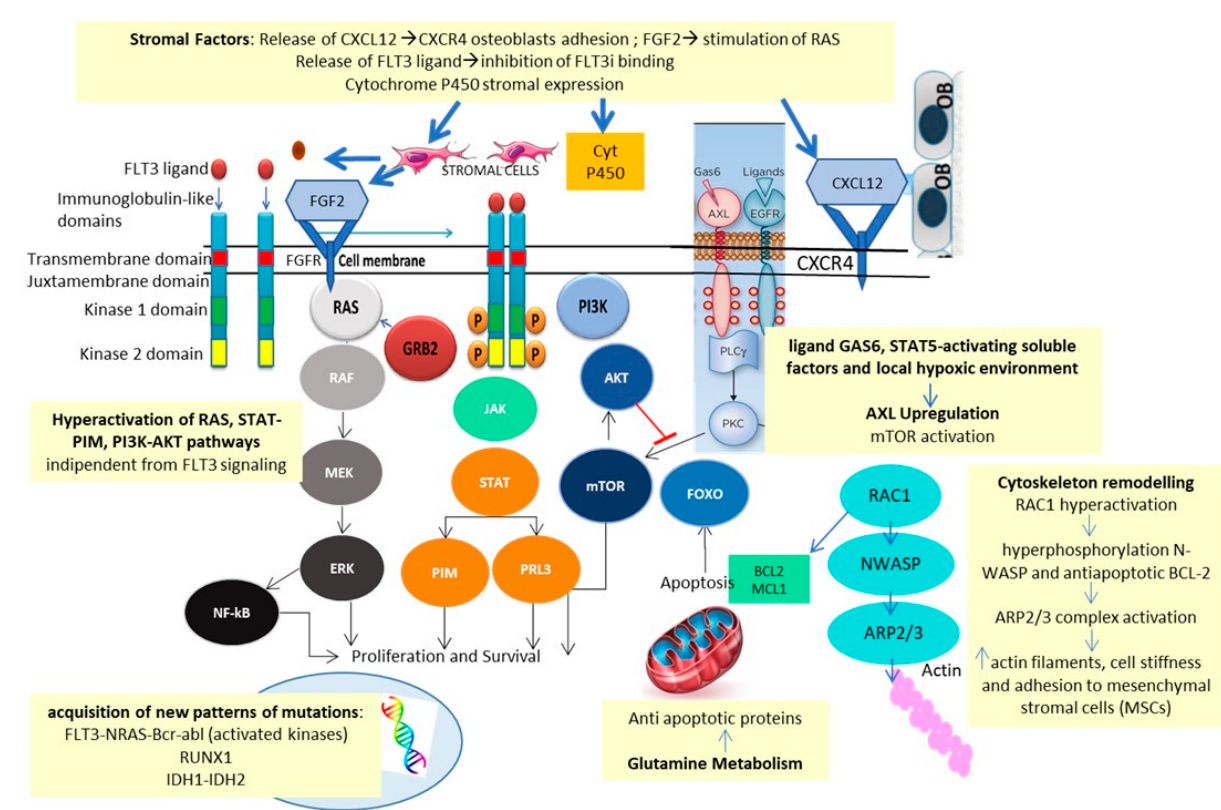
Figure 4. Mechanisms of resistance to FLT3i.